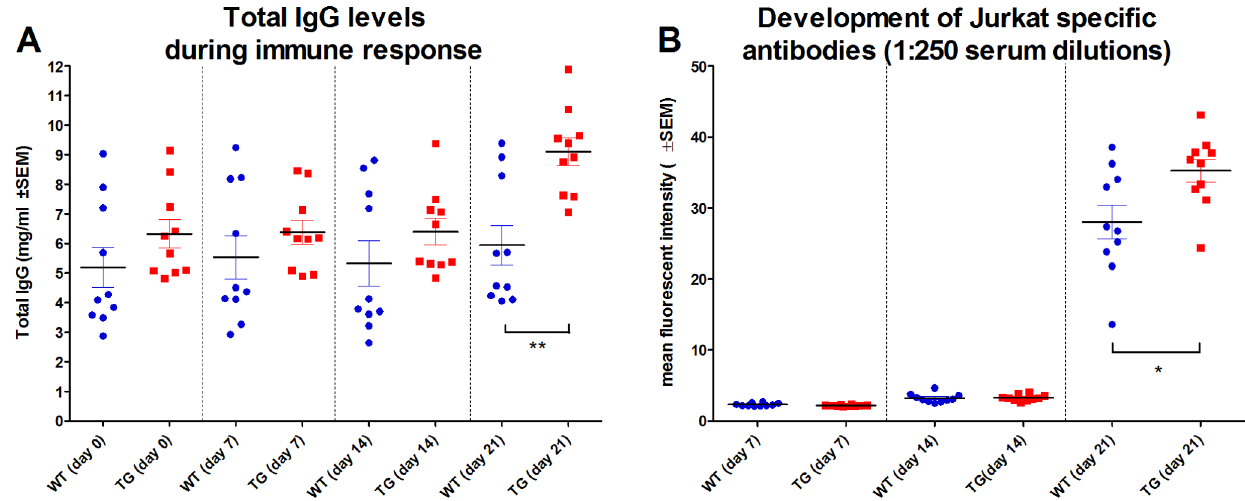
Figure 1. Kinetics of Jurkat specific immune response in Tg and wt rabbits. A. Total IgG concentrations of serum samples collected from rabbit FcRn transgenic (Tg) and wild type (wt) rabbits immunized with Jurkat T cells (determined by ELISA assay). B. Development of immune response to Jurkat T cell surface antigens during immunization (determined by flow cytometry binding assay of 1:250-fold diluted individual rabbit serum samples). Each dot represents one animal as an average of three measurements; (* P , 0.05; ** P , 0.01).